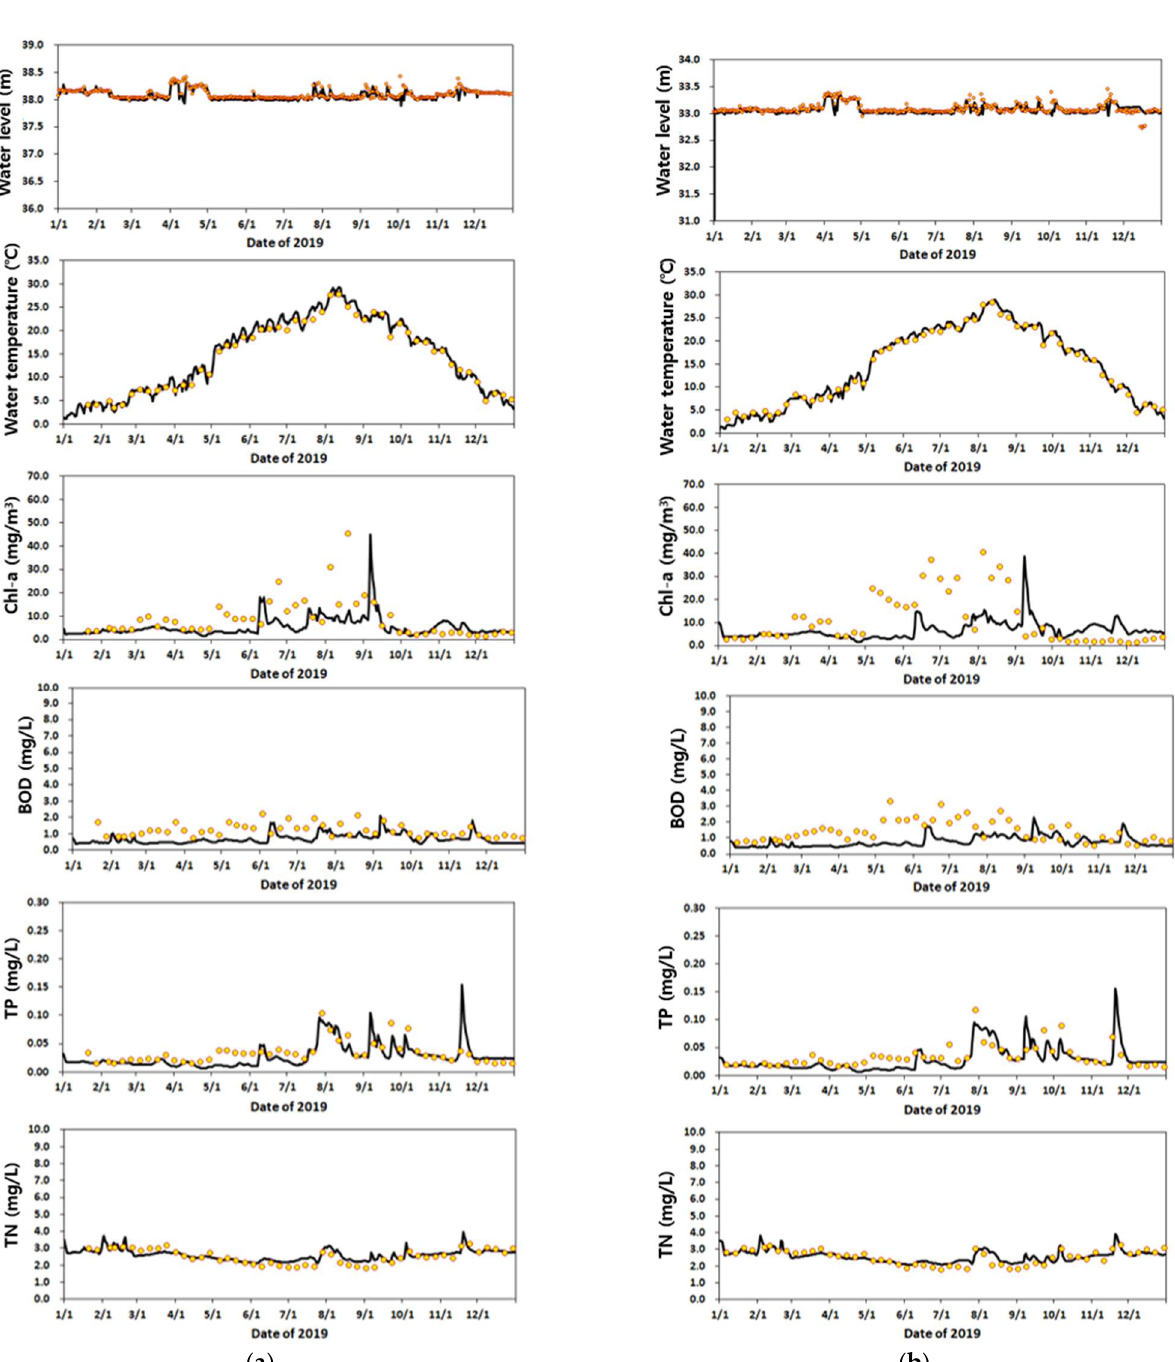
Figure 5. Calibration result for EFDC-NIER. ( a ) Upper reach of Gangcheon Weir. ( b ) Upper reach of Yeoju Weir Yeoju